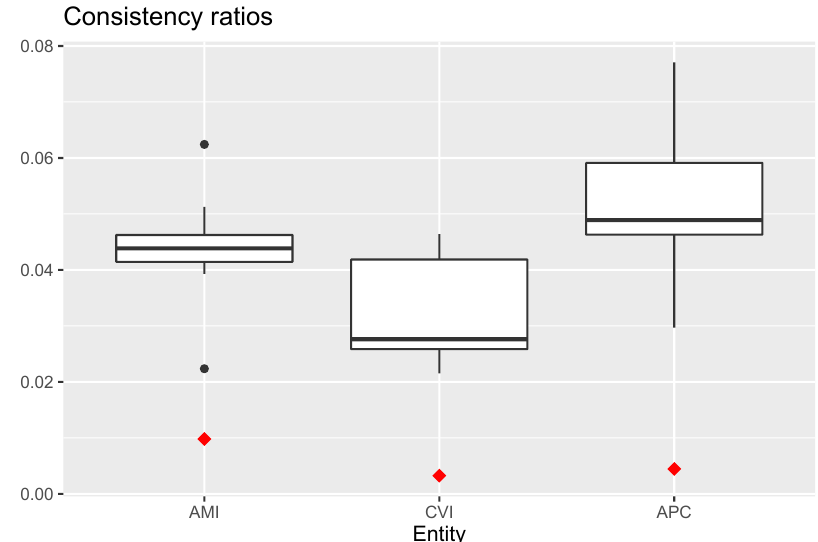
Figure 5. Boxplots of consistency ratio values for the three entities. Red diamonds indicate the value of consistency ratio for the group comparison matrices. AMI = acute myocardial infarction; CVI = cerebrovascular insult; APC = antimicrobial prophylaxis in colorectal surgery.